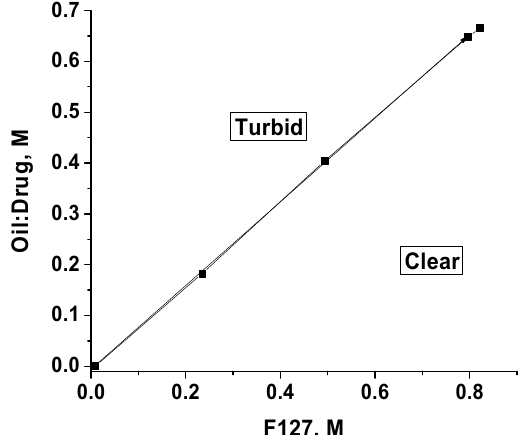
Fig. 7. Titration of turbid solution of F127, SC, oil+drug in PBS with oil+drug and F127 surfactant. The solution is clear below the curve and turbid above the curve.